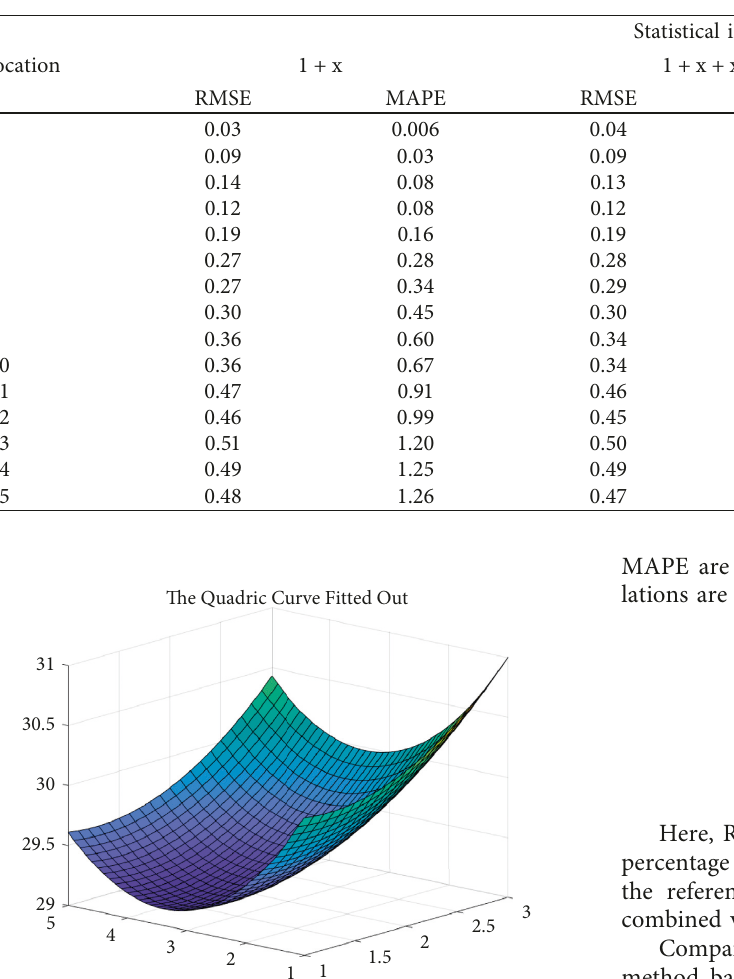
Table 3: Statistical index.